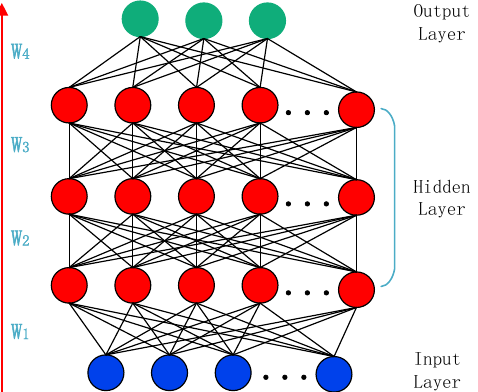
Figure 8. Topological graph of stacked autoencoder.